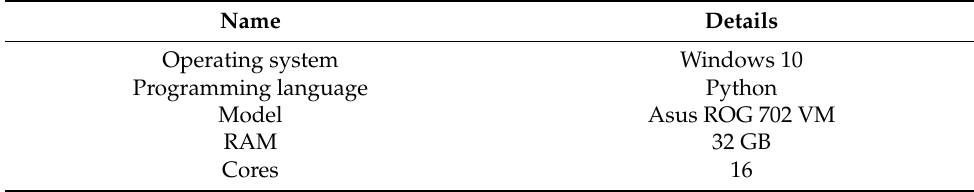
Table 3. System specification details.